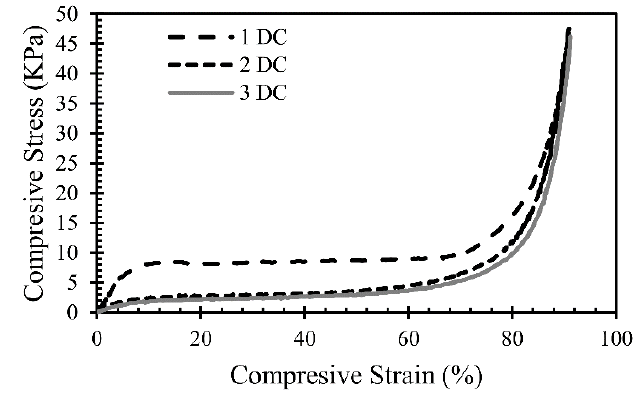
Figure 6. Stress vs. strain curve for foam samples with different dynamic compressions (DC), numbered as 1, 2 and 3. Table 2. Mechanical properties of the samples compressed at various percentages of their original length.